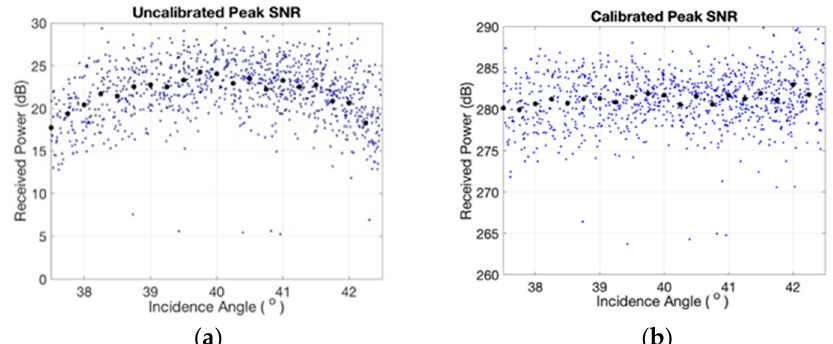
Figure 19. February 2018 SMAP-R samples as a function of the high gain antenna incidence angle: ( a ) uncalibrated and ( b ) calibrated. Note that calibrated values correspond to radar cross section values after applying calibration Equation (5), under coherent assumption.